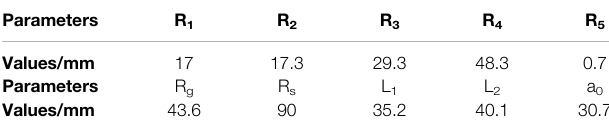
TABLE 1 | Dimensions of the proposed